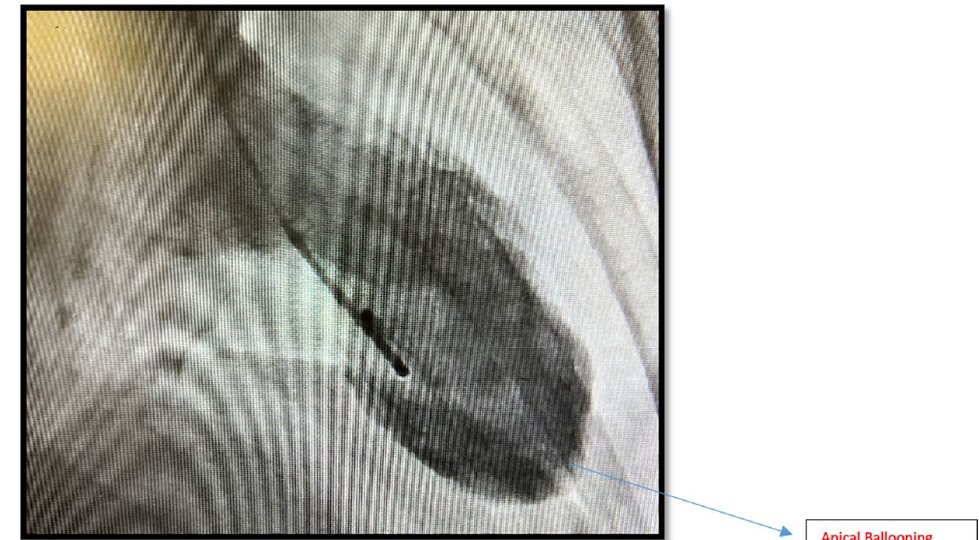
Fig. 8 Apical Ballooning—Case 2—Courtesy Dr Riley Batchelor (RMH)